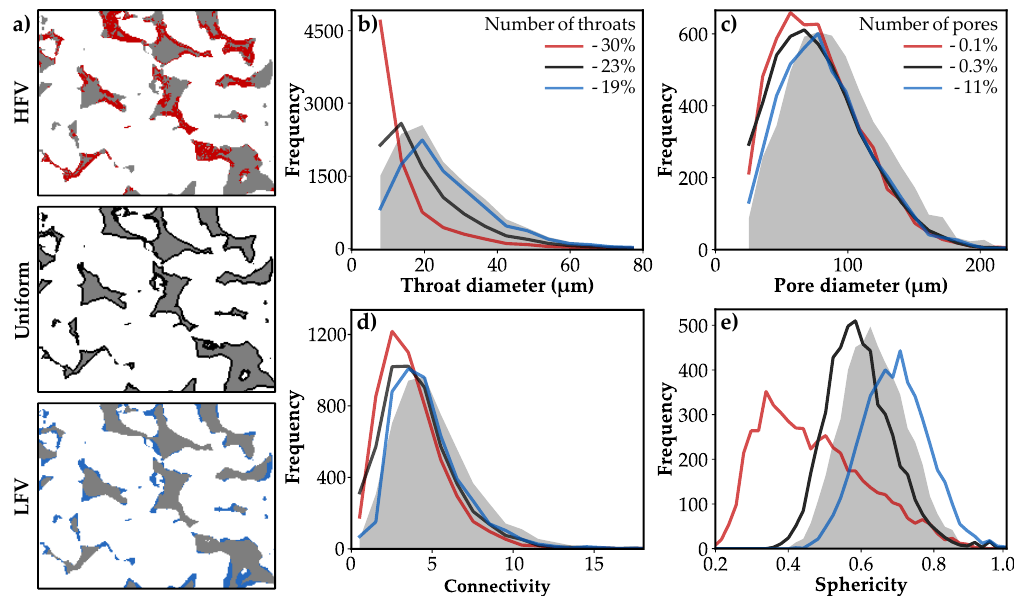
Figure 5. ( a ) Spatial alteration patterns at a porosity of 15.3% for preferential precipitation at high flow velocity magnitudes (HFV, red), low flow velocity magnitudes (LFV, blue) and uniform alterations, independent of fluid flow (black). Pore morphology for the three precipitation scenarios (coloured lines) and the initial pore structure (grey-filled) are described by ( b ) throat and ( c ) pore diameter, ( d ) connectivity, as well as ( e )